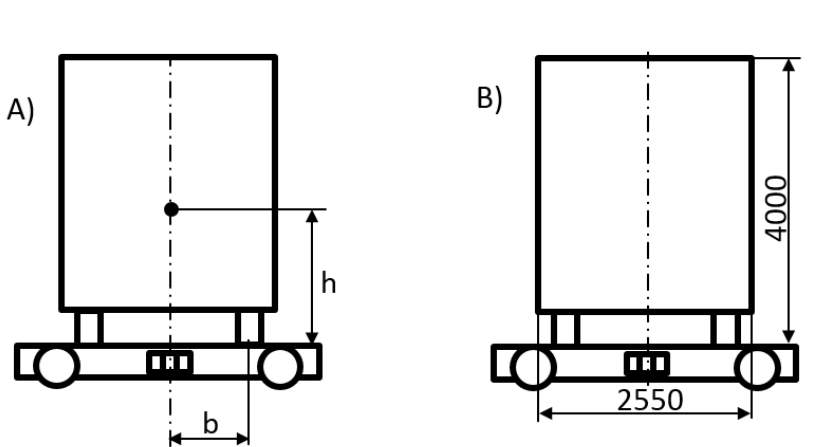
Figure 4. ( A ) Position of the mass centre and half-track width, ( B ) maximum dimensions; b —half- track width, h —height of the mass centre.